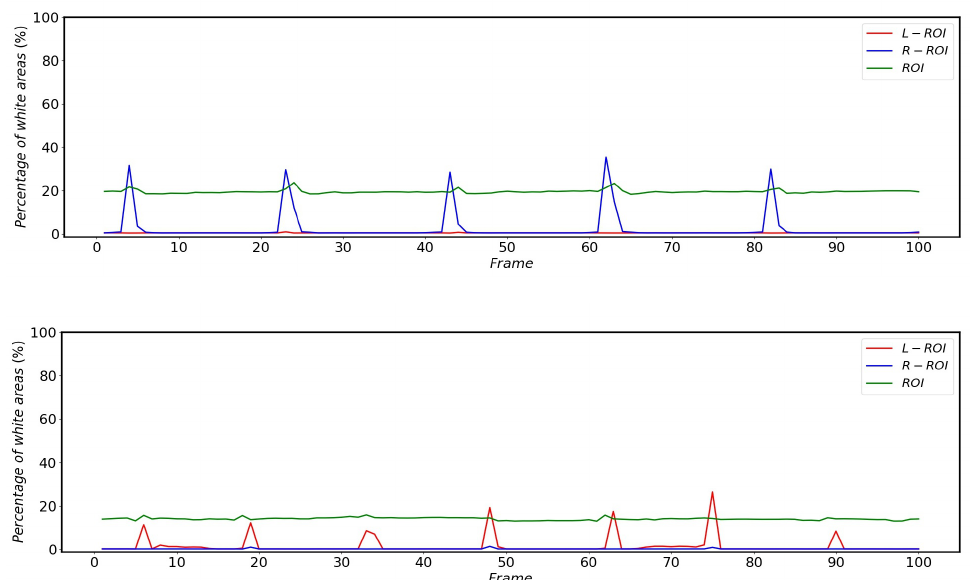
Figure 23. Changes in the percentage of white areas in the vertical projections of different areas of HSR-A ( top ) and HSR-B ( bottom ) during HSR operation after being affected by the catenary support devices.